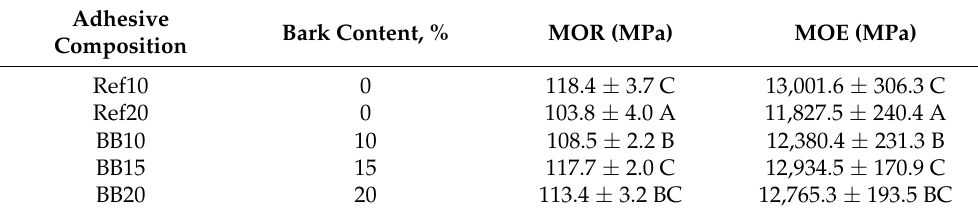
Table 5. Bending strength (MOR), and modulus of elasticity (MOE) values of plywood panels produced in this